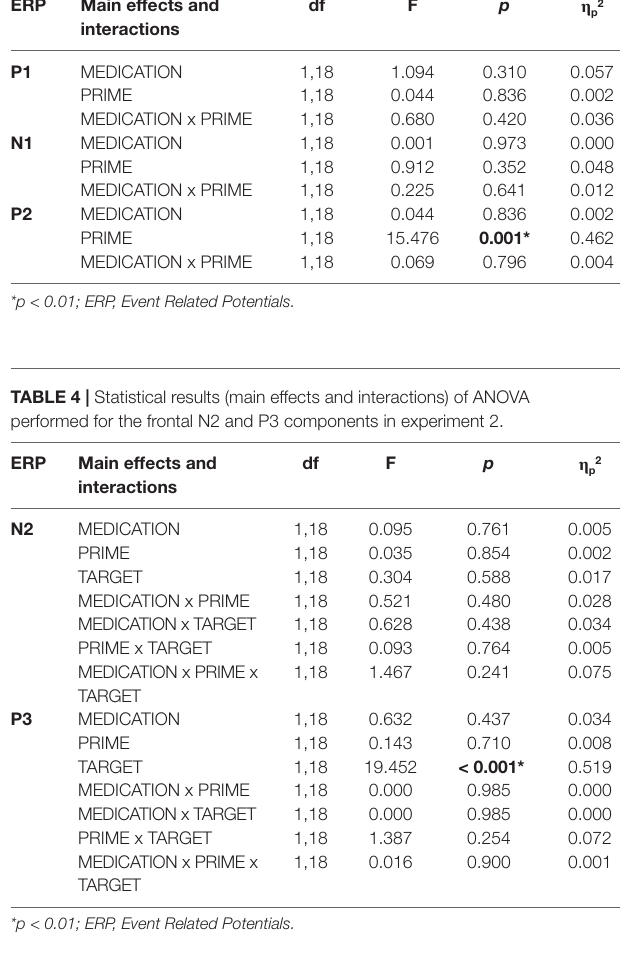
TABLE 3 | Statistical results (main effects and interactions) of ANOVA performed for the occipital P1, N1 and P2 components in Experiment 2. ERP Main effects and interactions